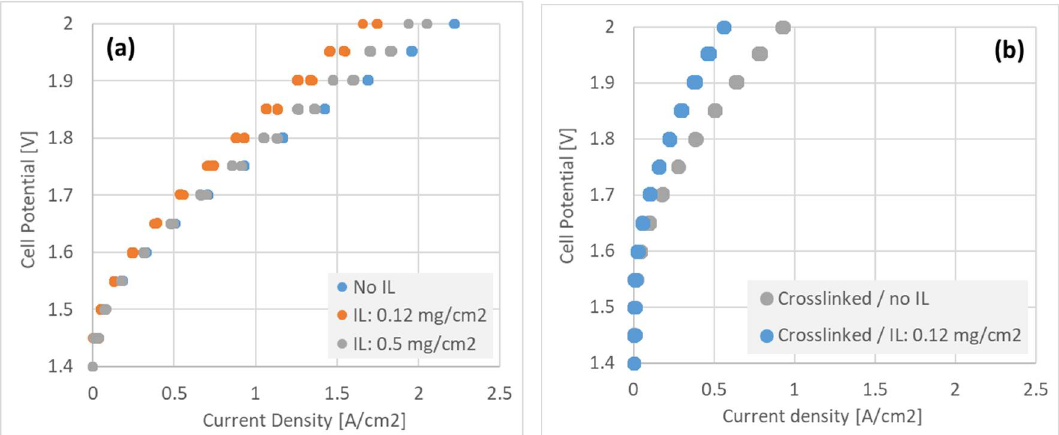
Figure 8. Polarization curves recorded for 5 cm 2 electrolyzer MEA’s with various configurations of GDE + interlayer, incorporating ( a ) uncrosslinked and ( b ) crosslinked (90:10 TMHDA:TMA amine ratio) ionomer.